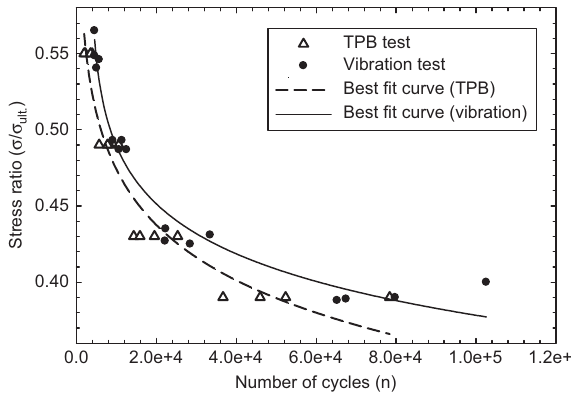
Figure 9 TPB and vibration S-N diagrams for FR7140 foam.